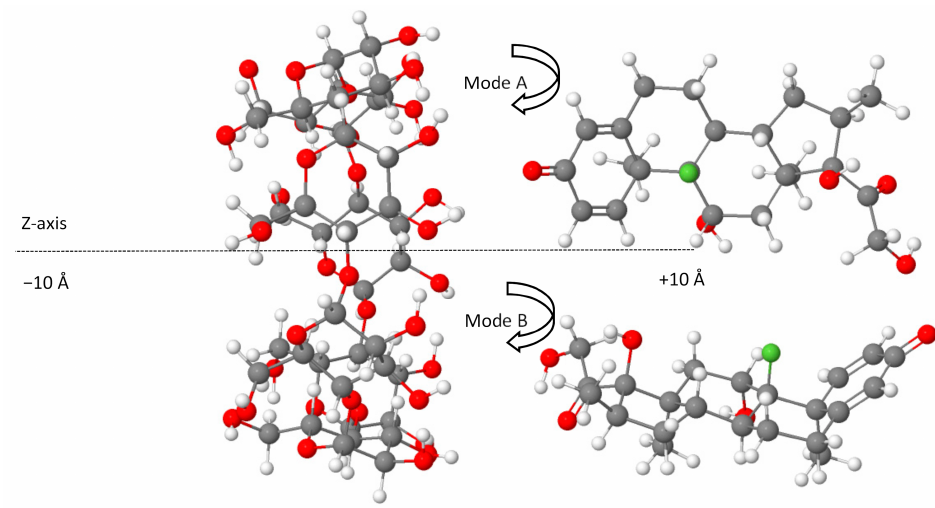
Figure 5. The generated initial set of configurations for a dexamethasone docking prediction from − 10 Å to +10 Å for A and B modes. Color code: carbon, grey; fluorine, green; oxygen, red; hydro- gen,